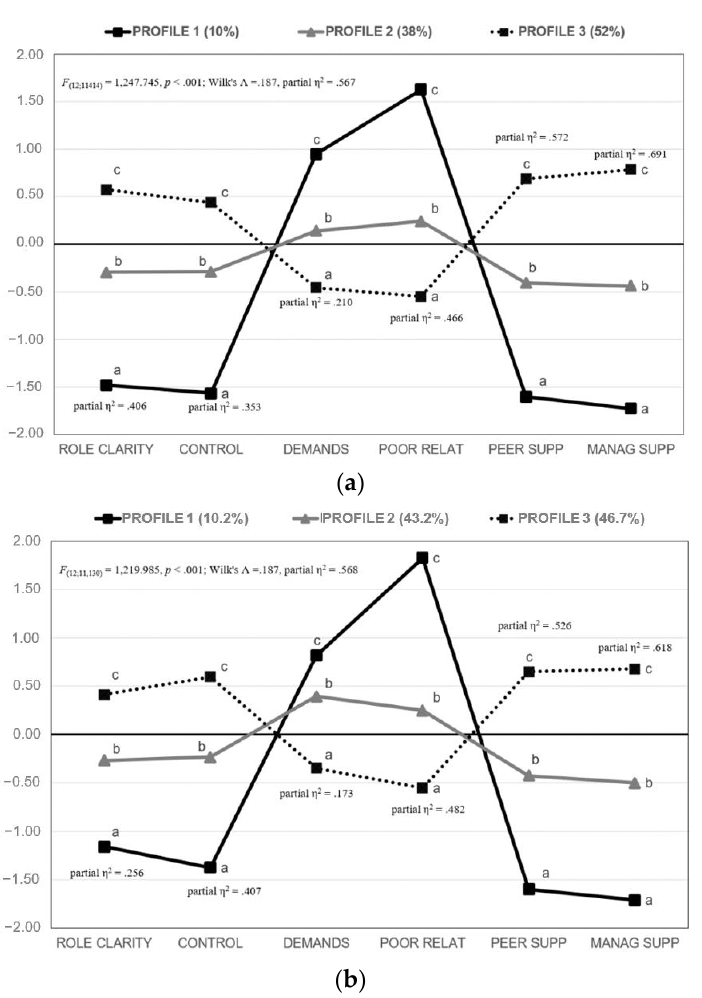
Figure 3. Final 3-Profile Solution for Men and Women. Note. Plotted scores were